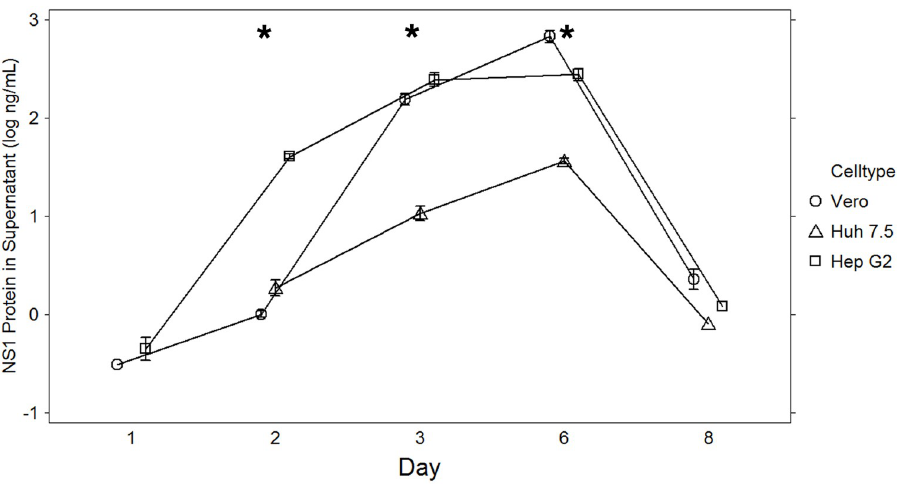
Fig 3. Zika NS1 protein. Measurement of Zika NS1 protein in target cell line supernatant over time, by ELISA. Results are expressed as the log ng/mL of the mean of 2–4 replicates in two experiments. Bars represent standard error of the mean. Asterisks denote data with statistically significant change from baseline.